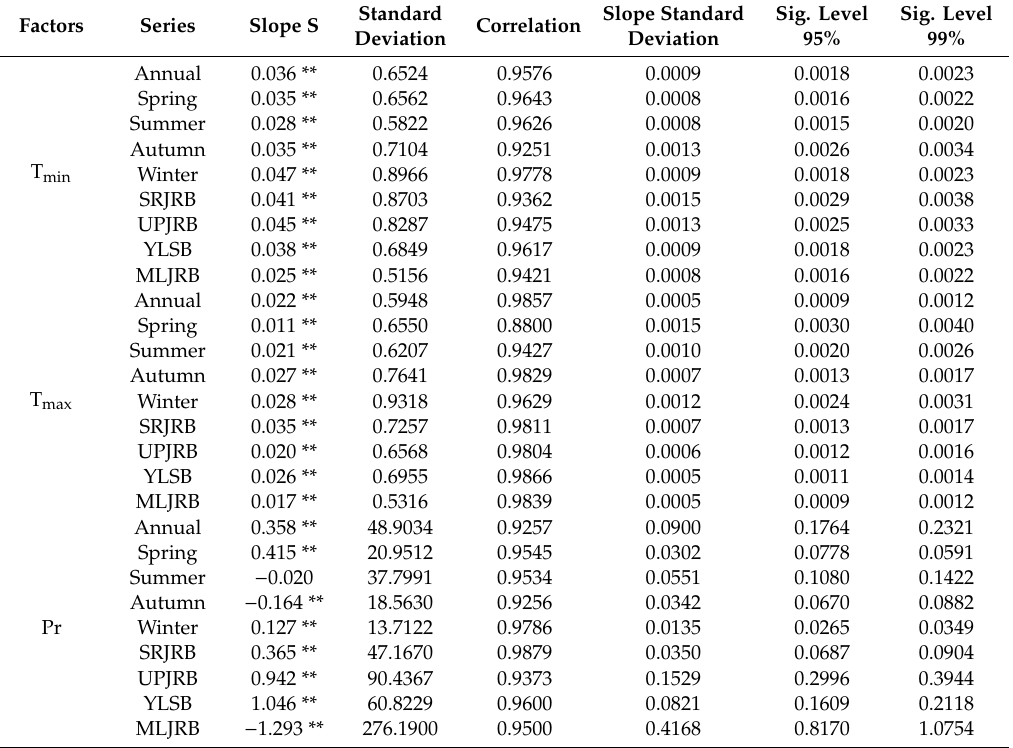
Table 3. Results of innovative trend analysis (ITA) statistic s for the minimum / maximum temperature and precipitation time